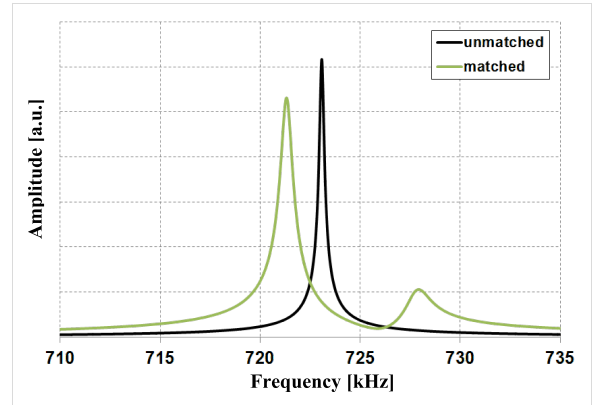
Figure 2: Calculated amplitude response for the cantilever (subsystem 1) with and without frequency matching between the two subsystems. The calculation is based on typical values for cantilever and FeCNT (see Table 1) and d 3 and k 3 are set to zero, assuming a system with- out interaction.